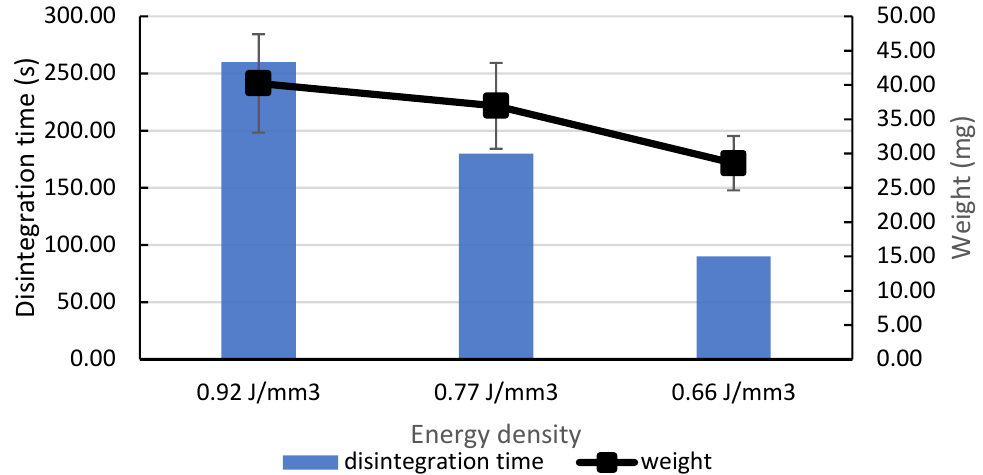
Figure 4. Effect of energy density on the disintegration time and weight of FH8 SLS tablets.